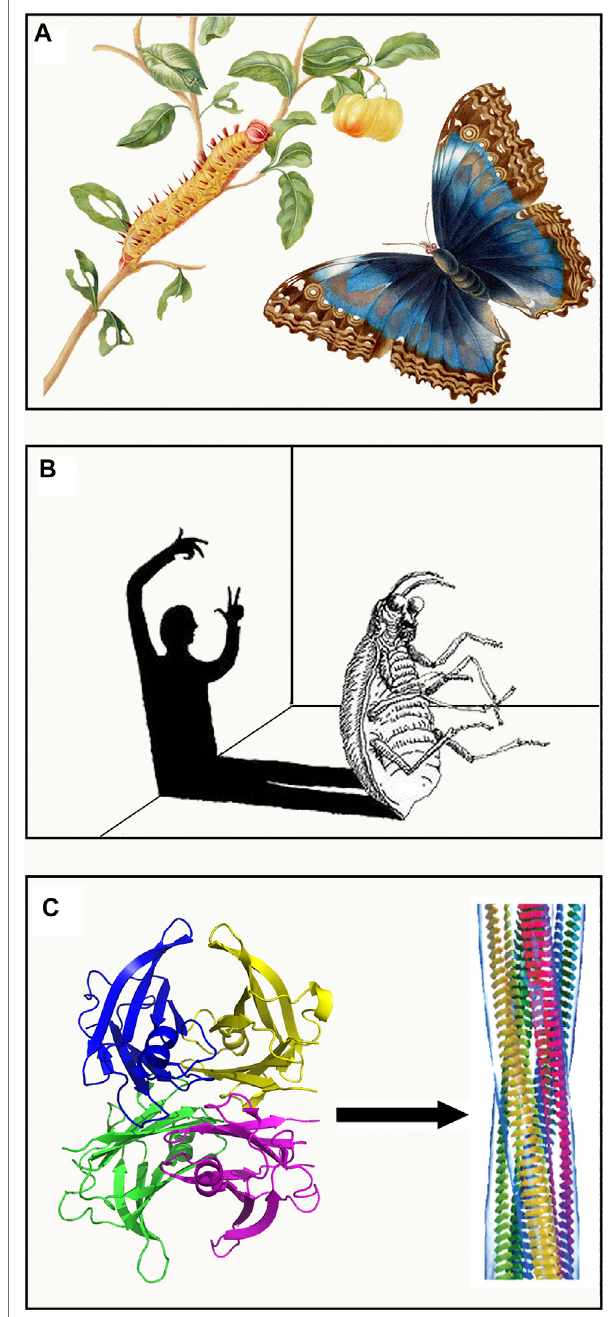
FIGURE 1 | Methamorphosis in nature and literature. (A) The caterpillar and butter fl y captured by the scienti fi c illustrator and naturalist Maria Sibylla Merian (1647 – 1717). (B) Representation of the nightmare in which Gregory Samsa is being transformed from human to a beetle. (C) The conversion of native tetrameric TTR into amyloid fi brillar structures marks the protein transition from a physiological to a pathologic role. Both artworks in (A,B) are in the public domain. Structure of amyloid fi brils from (Chiti and Dobson, 2017) are reprinted with permission from Annual Reviews, Copyright